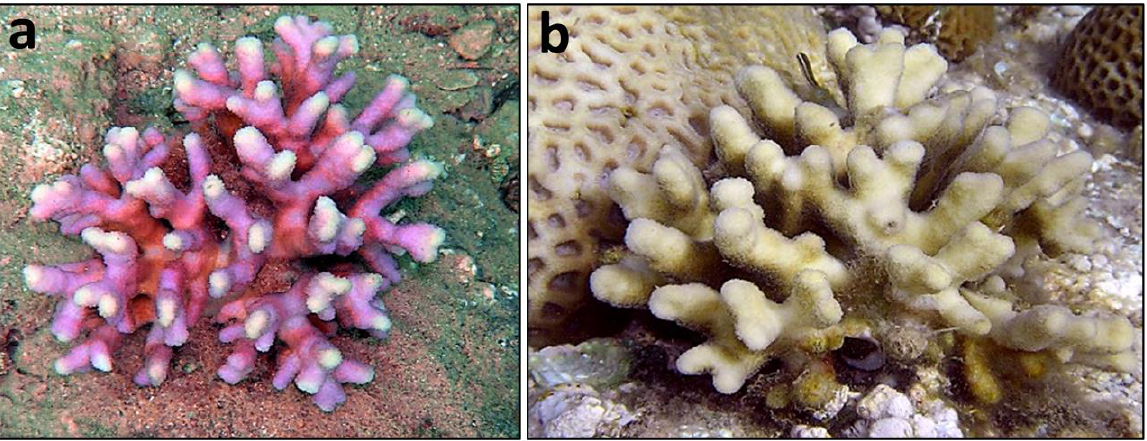
Figure 1. Stylophora pistillata (Esper 1797) colonies ( a , b ) form the Gulf of Eilat (phots: E. N. Rachmilovitz).